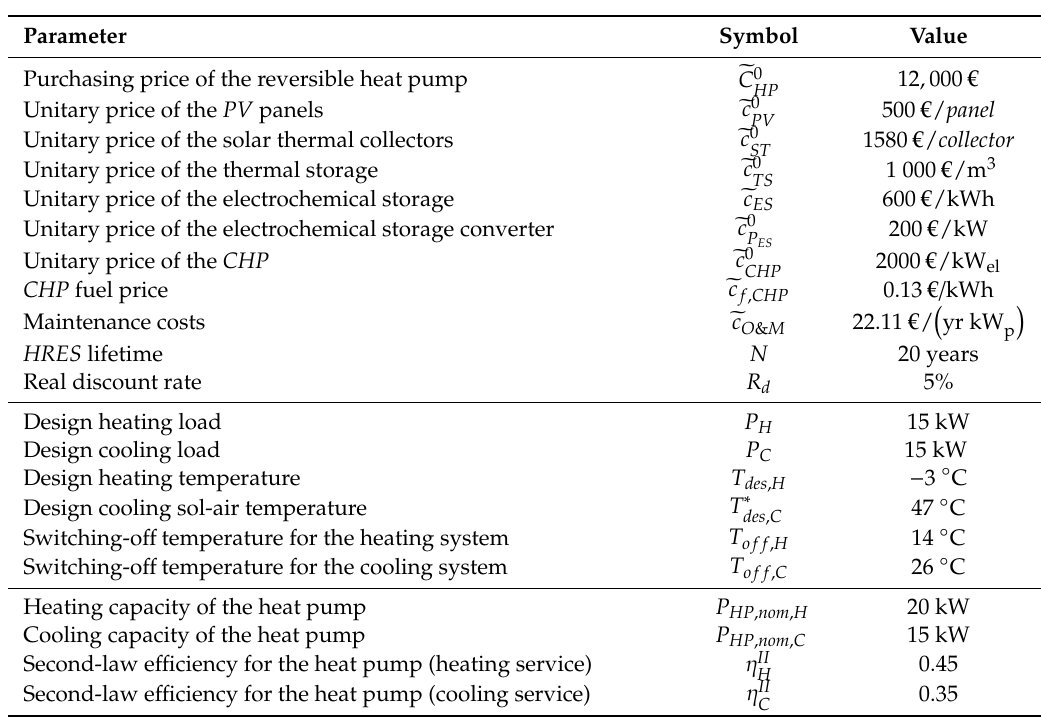
Table 4. Parameters used in the case